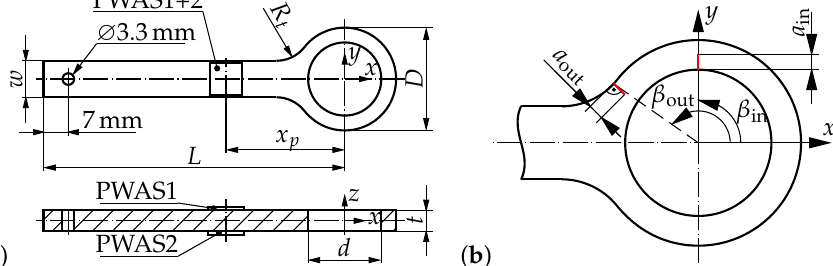
Figure 1. Geometry of simple lug, ( a ) dimensions of the lug and PWAS positions; ( b ) size and locations of investigated